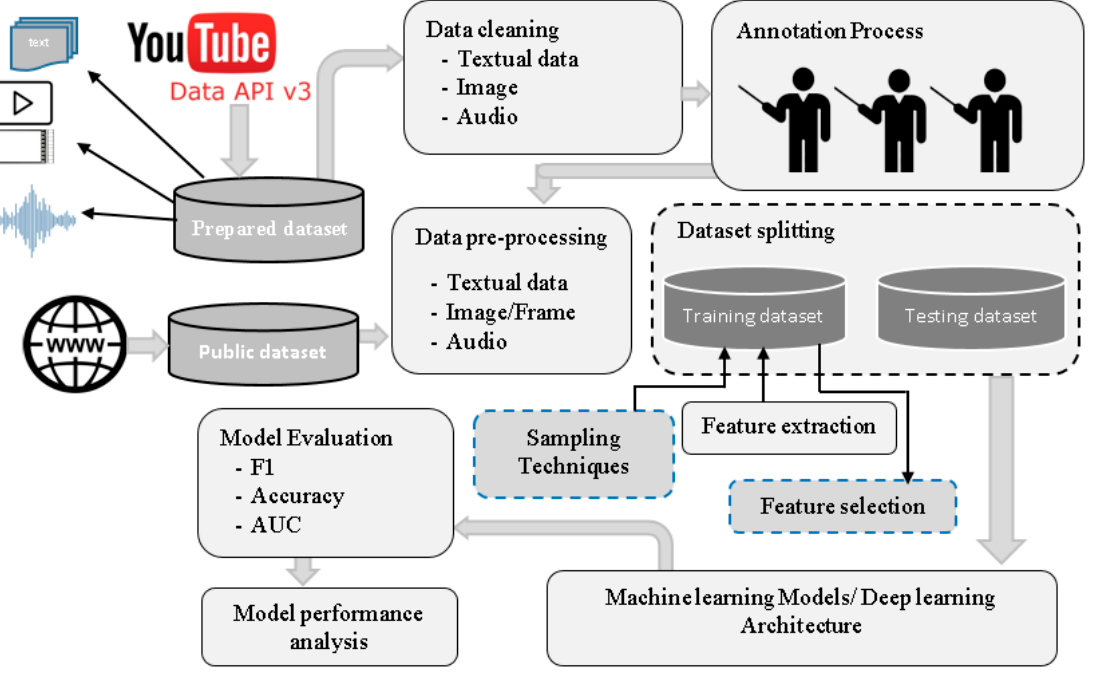
Figure 5. A general view of methods used for detecting inappropriate YouTube Kids videos using machine/deep learning approaches.